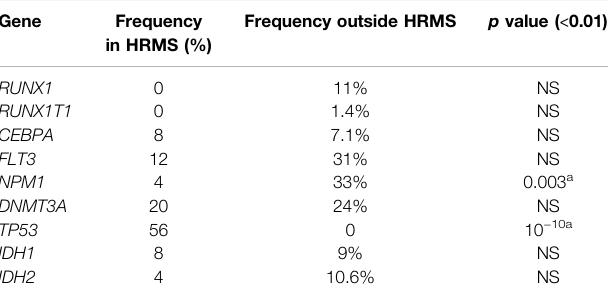
TABLE 1 | Frequencies of mutation in AML genes in HRMS subgroup, versus other patients. p -values are from Fisher ’ s exact tests on counts of mutant and wild-type genes.